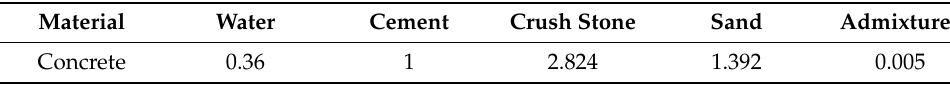
Table 1. Concrete grout mixture proportions.